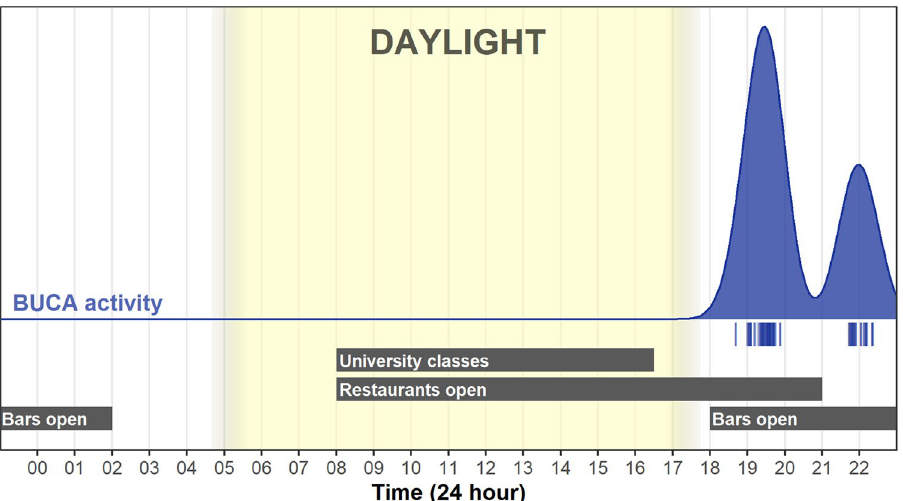
Figure 6. Daily shelter site emergence activity patterns of B. candidus based on observation via camera traps (blue density plot and points). Below are several potential drivers of human movement about campus, as well as the daylight hours (the gradient shows the variation in sunrise/set during the year). This figure was created using R v.4.0.5 (https://r- proje ct. org/) in RStudio v.1.4.1106 (https:// rstud io.